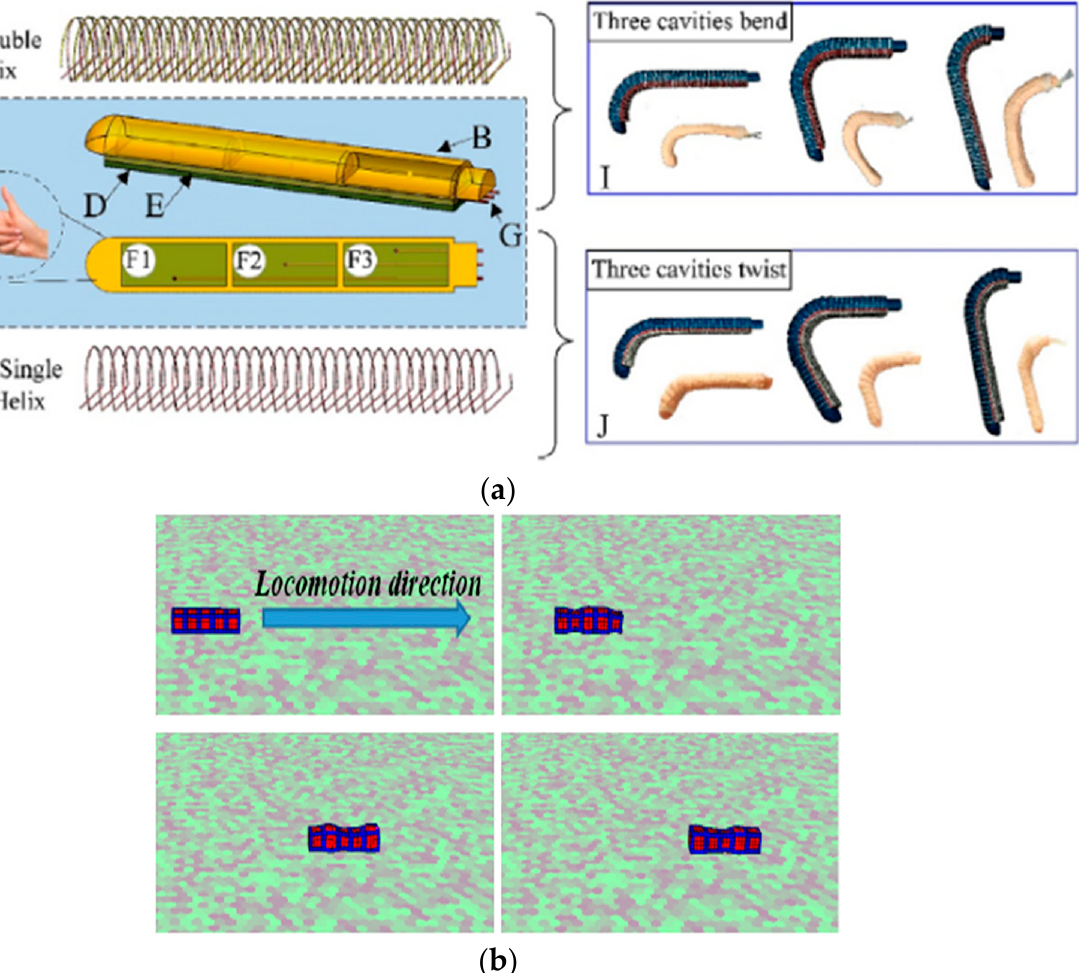
Figure 3. ( a ) Finger actuator structure; reproduced with permission from [28]; published by ELSE- VIER, 2019; ( b ) modular robot simulated in VoxCAD software [30].